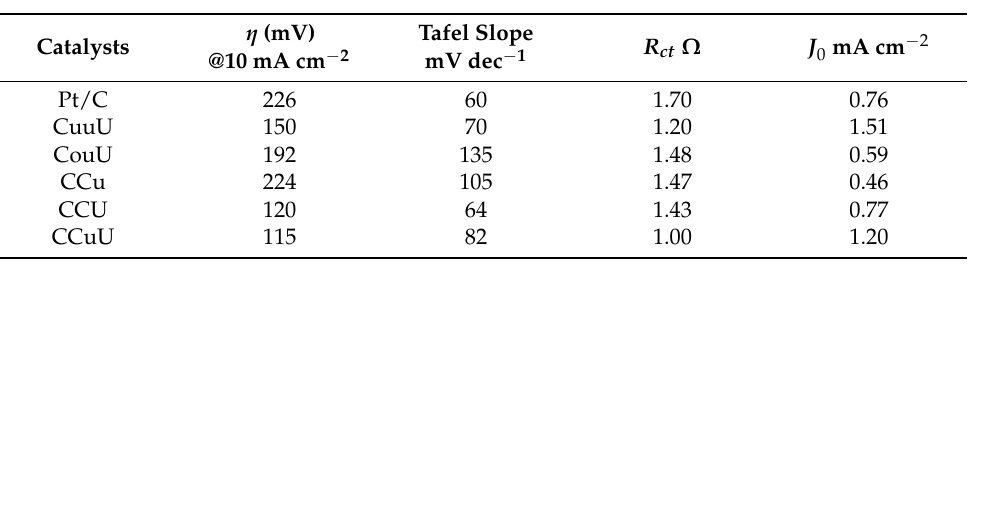
Table 1. Account of the catalytic activities of the materials in the alkaline NaCl